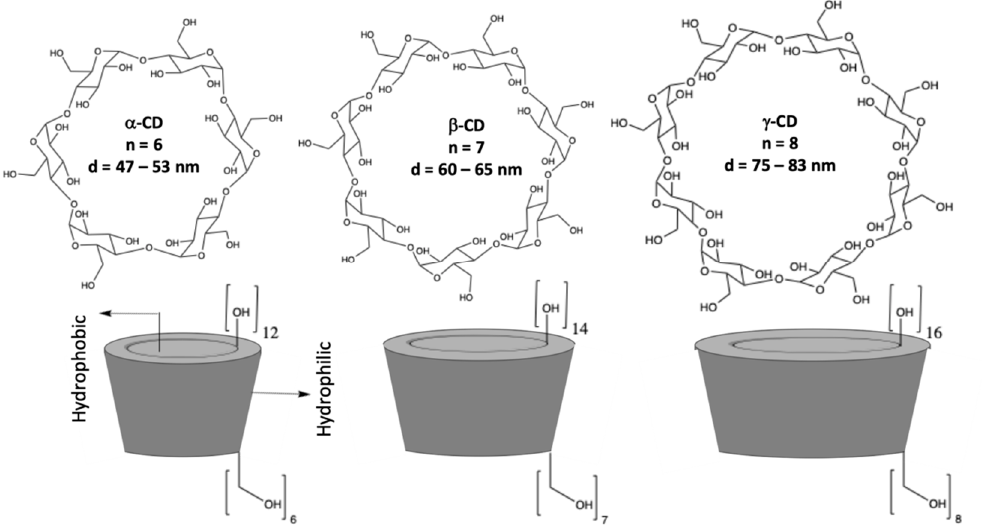
Figure 1. Structures of α -, β -, and γ -CDs (cyclodextrins) and a schematic of the conelike structures.